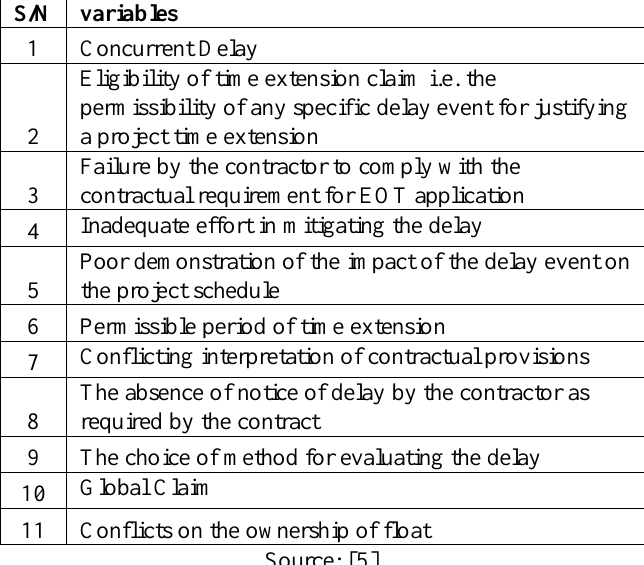
Table 2: Disputed Issues Associated with EoT